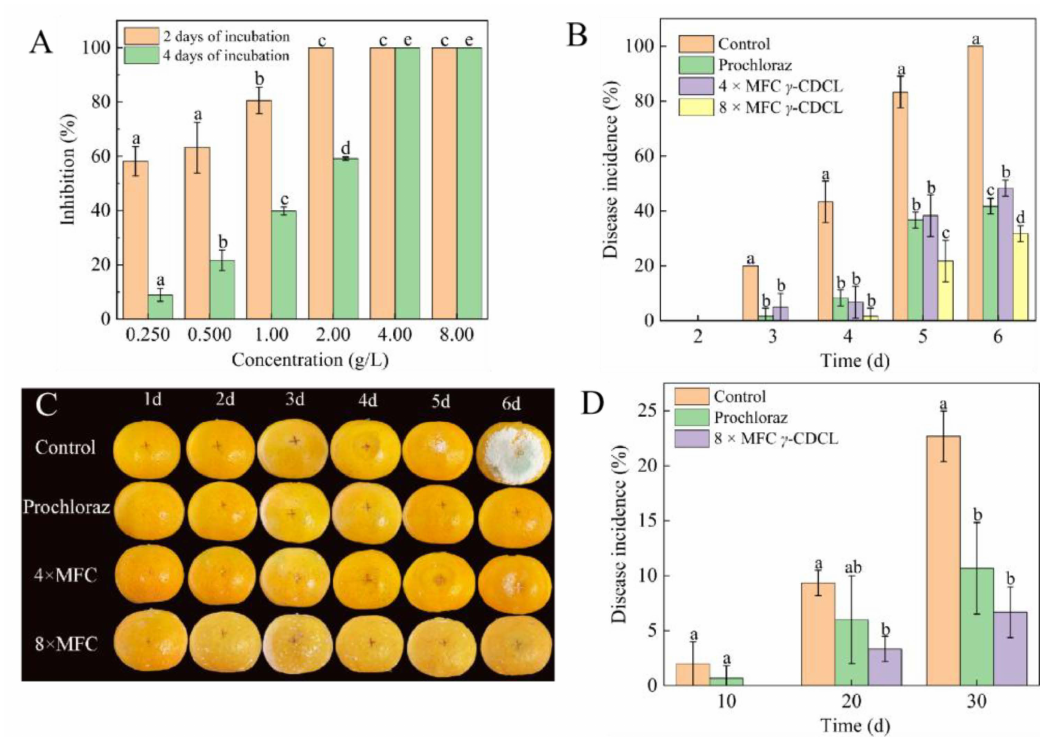
Figure 1. Evaluation of γ -CDCL on the mycelial growth of P. digitatum after 2 and 4 days of culture ( A ); Green mold disease incidence ( B ) and growth progression ( C ) in inoculated citrus fruit treated with γ -CDCL (0 × , 4 × , and 8 × MFC) and Prochloraz (0.025% in water, v / v ) during storage at 25 ± 2 ◦ C for 6 d and 85–90% RH; Decay rate of citrus fruit under natural storage conditions for 30 days ( D ). Dissimilar lowercase letters in the histogram express the statistical significance among different treatments at the same time. Data are expressed as the mean ± standard deviation of pooled data ( n = 3, p < 0.05). γ -CDCL, cinnamaldehyde/ γ -cyclodextrin inclusion complex; MFC, minimum fungicidal concentration; RH, relative